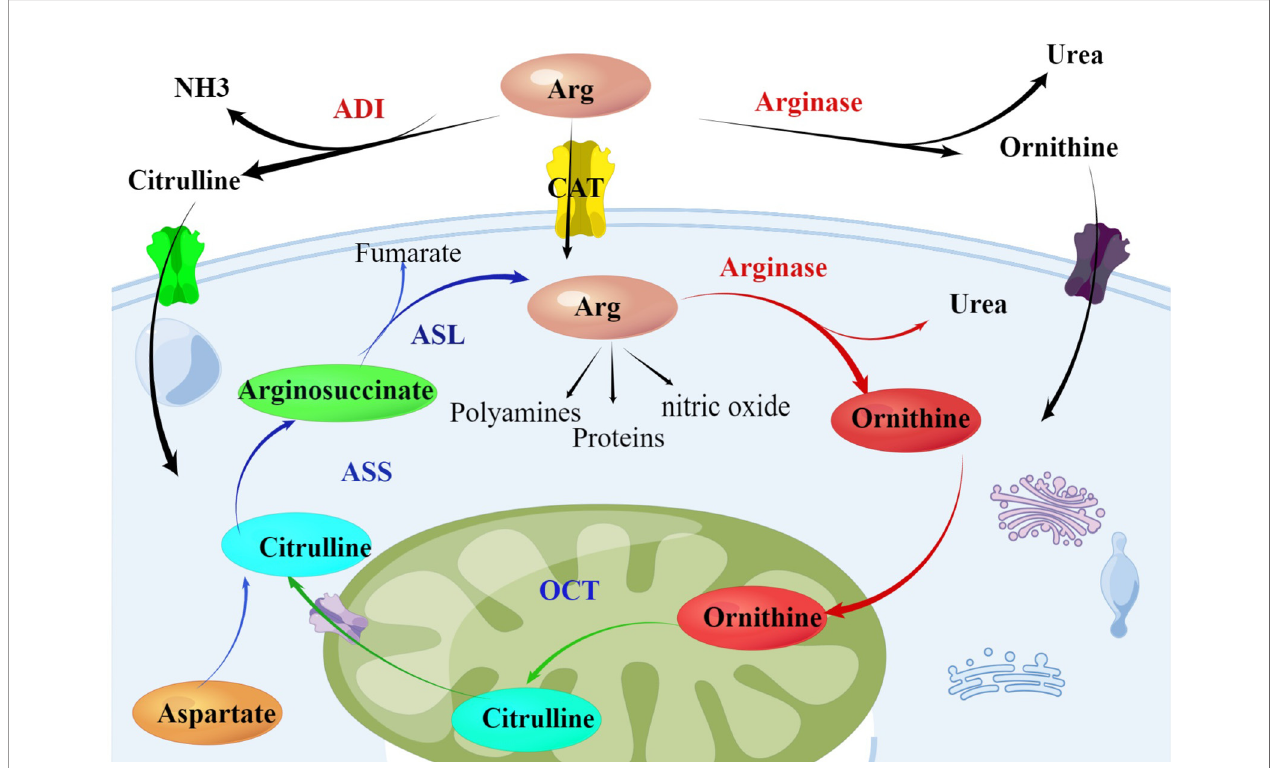
FIGURE 1 | Arginine metabolism within the urea cycle: Arginase catalyzes the hydrolysis of arginine into ornithine and OCT catalyzes the synthesis of citrulline from ornithine. Aspartate and citrulline are condensed by the enzymatic activity of ASS and the resulting intermediate arginosuccinate is then split by ASL, producing again arginine. Tumor cells lacking the enzyme ASS rely on exogenous supply of arginine. The endogenous sources of arginine can be used as a potential therapeutic intervention targets in treating cancer. Arg, Arginine; ADI, arginine deiminase; ASS, argininosuccinate synthetase; ASL, argininosuccinate lyase; OCT, ornithine